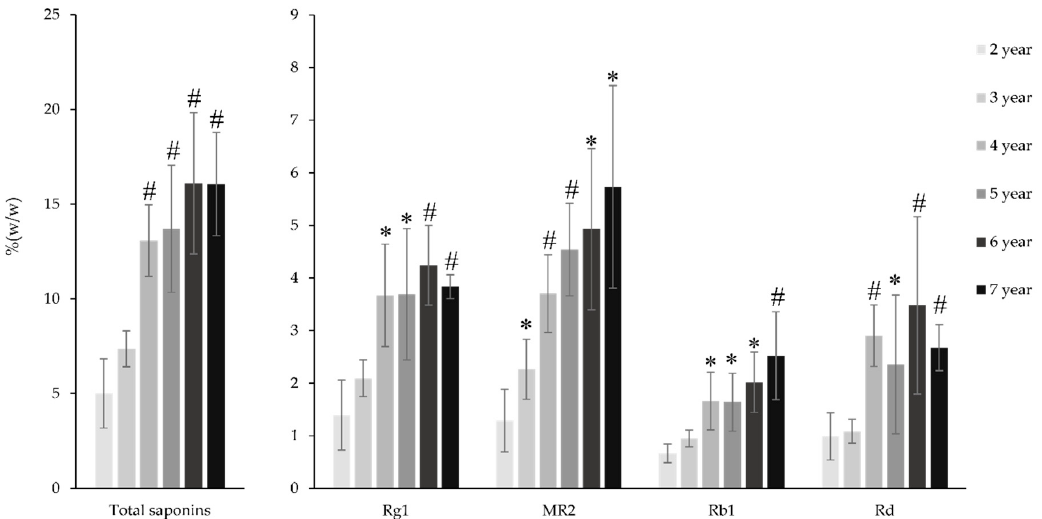
Figure 6. Change of saponin content of the PV rhizome from 2 to 7 years. Results are expressed as mean ± SD ( n = 5), * p < 0.05, # p < 0.01 compared with that at the age of two years.